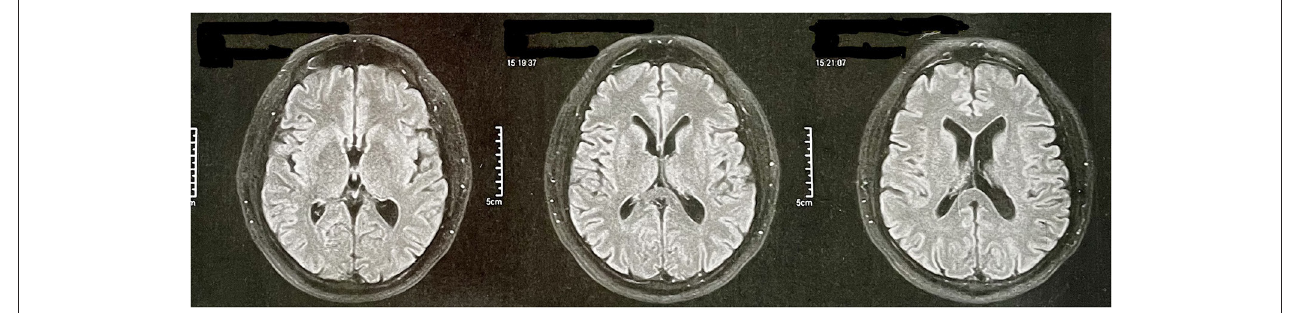
FIGURE 2 | Patient’s magnetic resonance angiography data. The magnetic resonance images are restricted to the T2 FLAIR sequence and only axial because they are derived from an angiographic